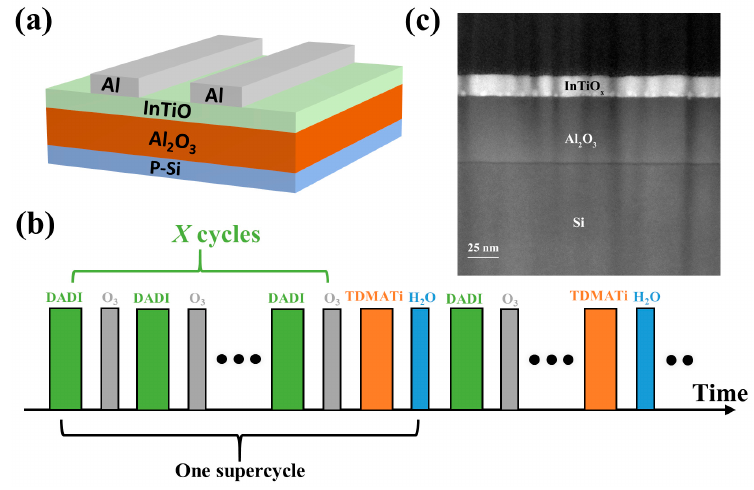
Figure 1. ( a ) The schematic structure of the InTiO TFT. ( b ) The cycle design of the ALD process for the thin films. ( c ) Cross-sectional TEM image of an InTiO TFT.